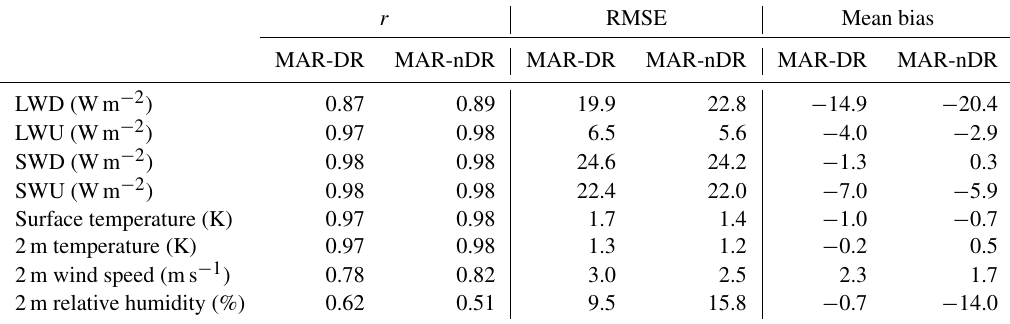
Table 2. Root mean square error (RMSE), Pearson correlation coefficient, and mean bias computed at D17 for MAR-DR and MAR-nDR half-hourly simulations in comparison with in situ observations.